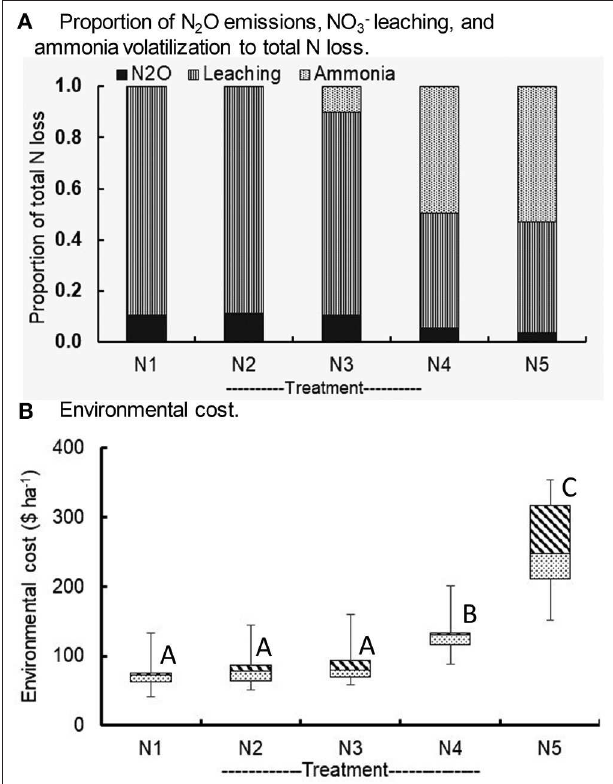
FIGURE 3 | Ten-yr average proportion of three nitrogen loss pathways (N 2 O emissions, NO 3 − leaching, and ammonia volatilization) and their environmental costs. In the treatments, 30kg N ha − 1 was applied at planting and rest was sidedressed in the growing season. Total N rates in five treatments were as follows: N1: 30kg N ha − 1 ; N2: 57kg N ha − 1 ; N3: 87kg N ha − 1 ; N4: 145kg N ha − 1 ; N5: 218kg N ha − 1 Treatments indicated by letters are